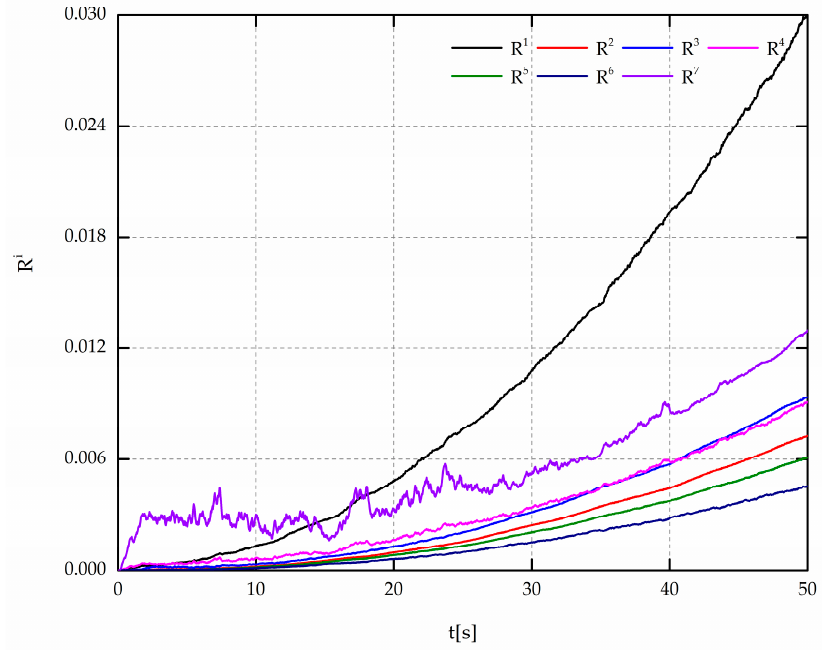
Figure 10. Fault indicator signals of the bank of SMOs in Mode 2.